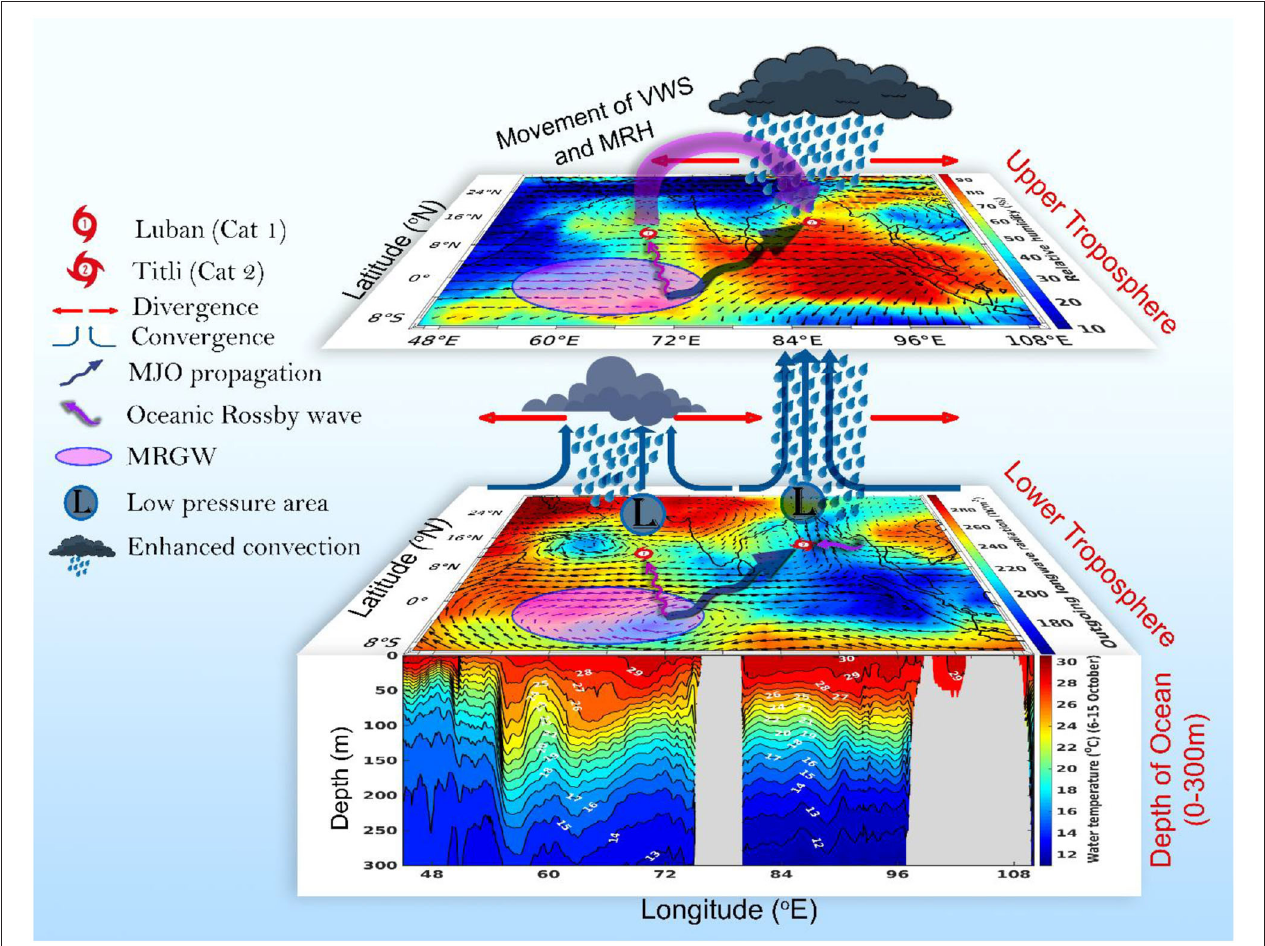
FIGURE 15 | A schematic diagram represents the ocean-atmosphere dynamics associated with the simultaneous genesis of cyclone Luban in the AS and Titli in the BoB over the North Indian Ocean. The lower (vertical) panel depicts the vertical temperature structure during October 6–15, 2018 (the cyclone period) in the upper 300-m depth. The middle (horizontal) panel depicts the outgoing longwave radiation (W/m 2 , shading), superposed with the lower tropospheric wind (m/s) at 850 hPa, and the upper (horizontal) panel depicts mid-tropospheric-relative humidity (%, shading) at 500 hPa, superposed with the upper tropospheric wind (m/s) at 200 hPa. VWS and MRH denote vertical wind shear and mid-tropospheric-relative humidity, respectively, moving from the AS to the BoB, indicated by the curved thick magenta arrow. MJO and MRGW stand for Madden–Julian oscillation and mixed Rossby-gravity wave. Refer to text for details.